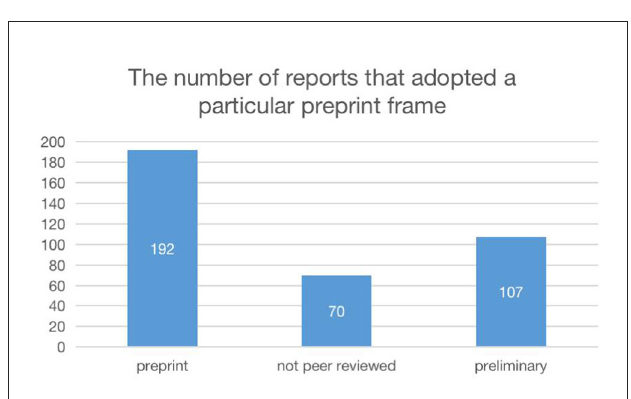
FIGURE2 The number of reports that adopted a particular preprint